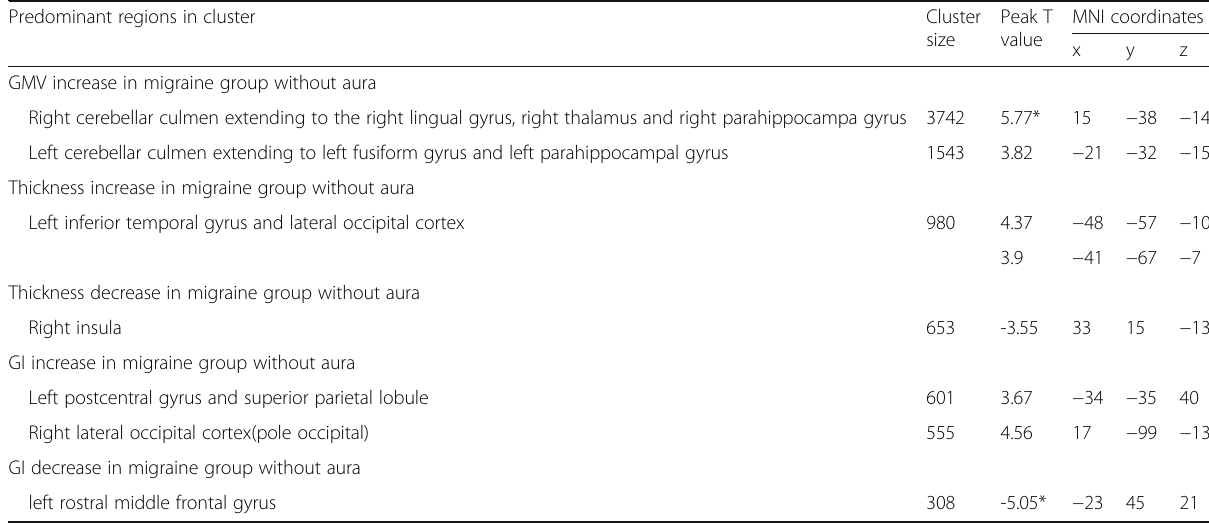
Peak T MNI coordinates size value x y z